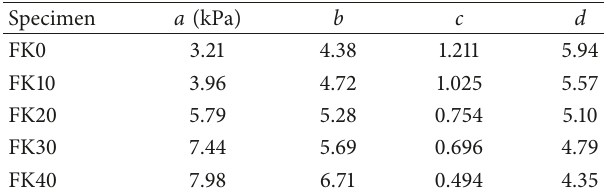
Table 5: Parameters a , b , c , and d for permeability function of soil specimens for (4).